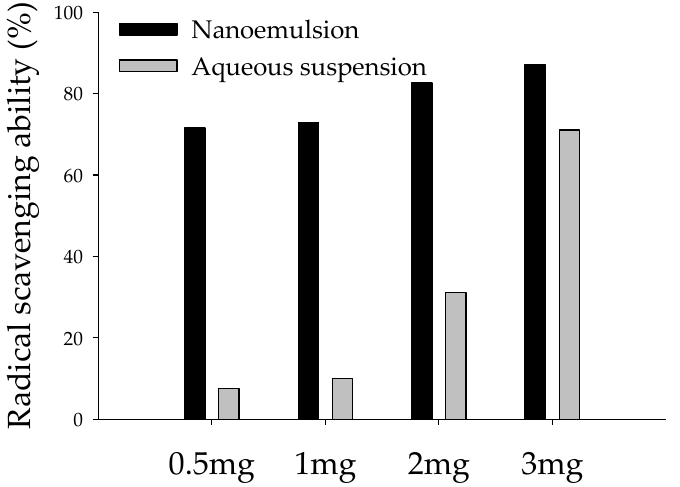
Figure 3. Antioxidant capacity of pterostilbene nanoemulsion and water suspension.